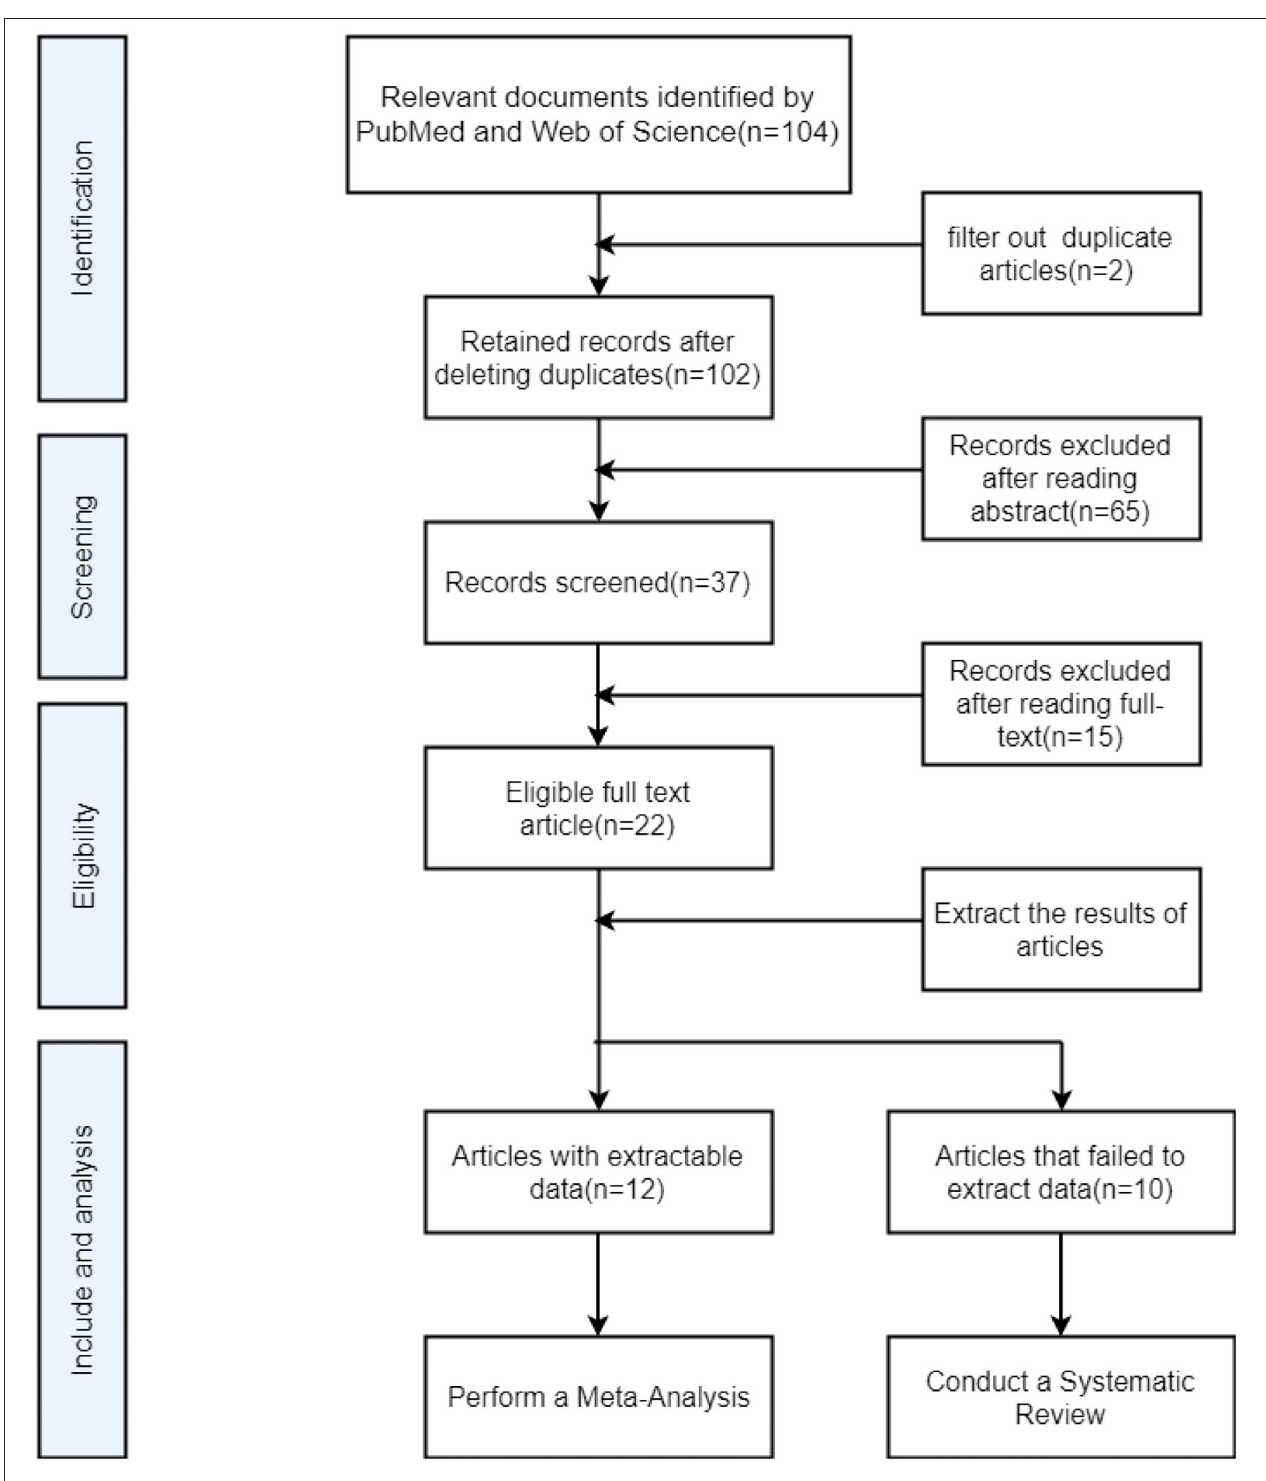
FIGURE 1 | Flow chart for searching and screening articles included in meta-analysis and system review.